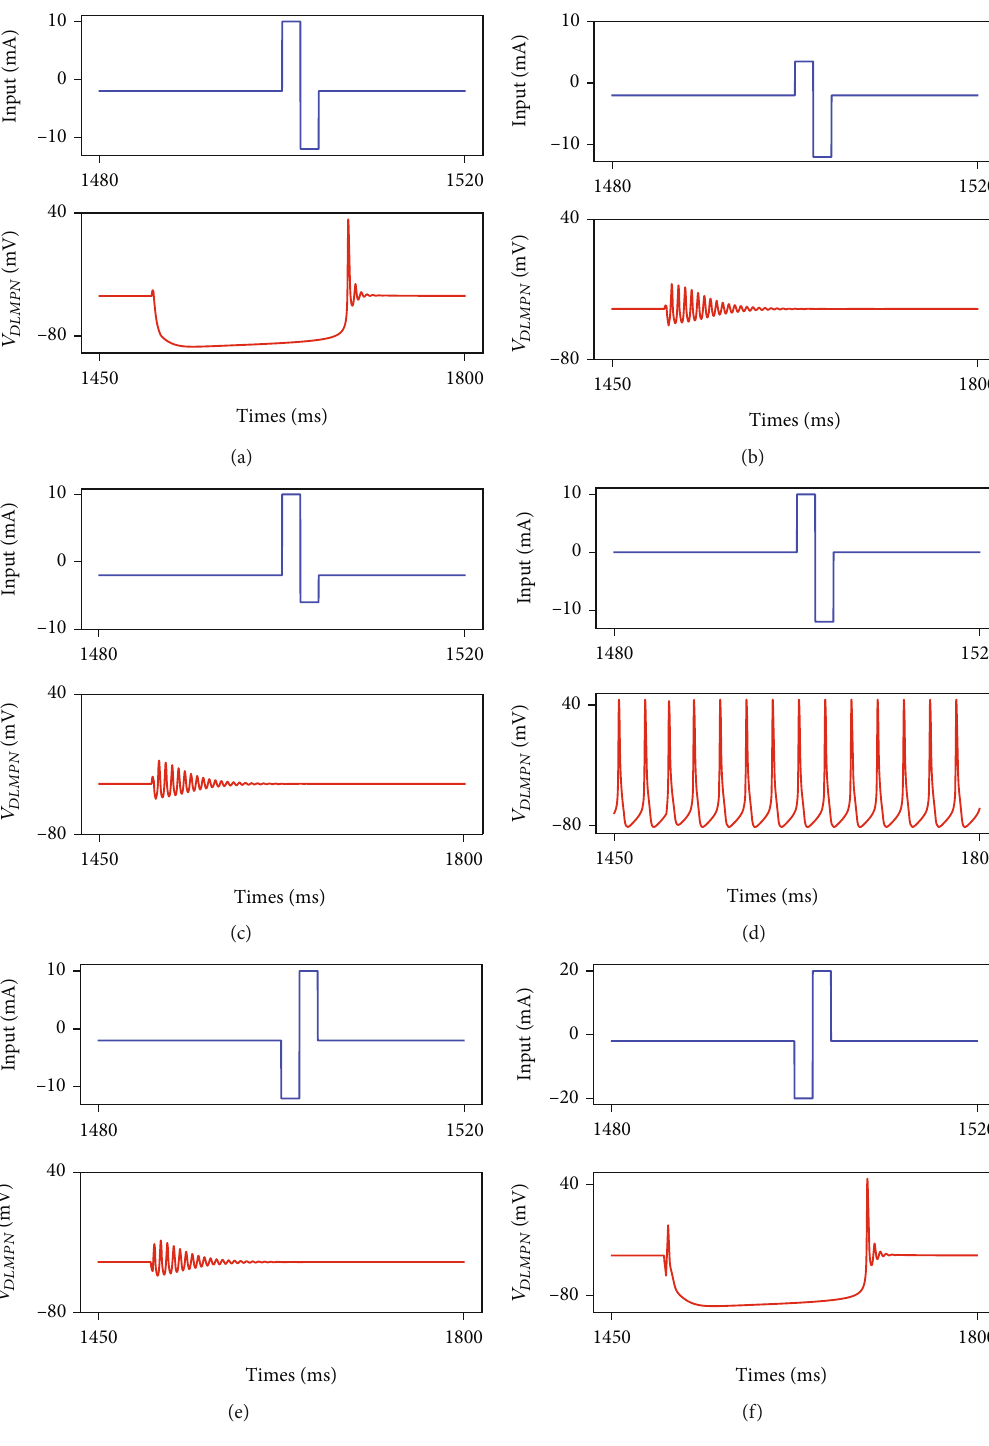
= − 2 mA , I nor = 10 mA , and I = − 5mA . (d) I pos neg = − 2mA , I = 20mA , and I nor pos lasting the other nor